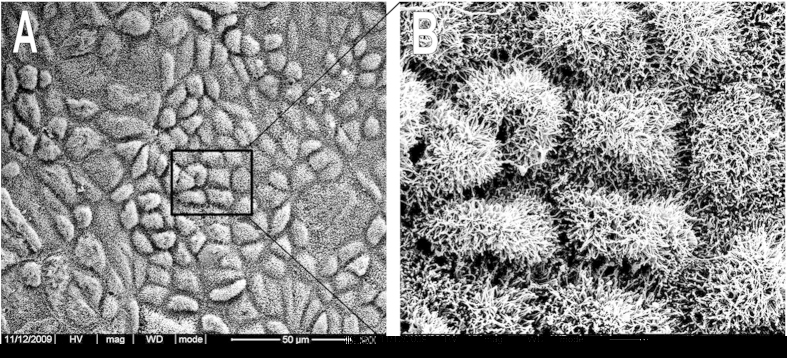
SEM image of surface of healed abdominal wall (A) and the image with higher magnification (B) in Dex hydrogel group.Microvilli on mesothelial cells were observed.